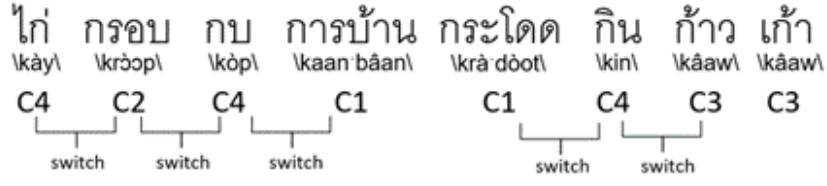
Figure 4. Illustration for switching.